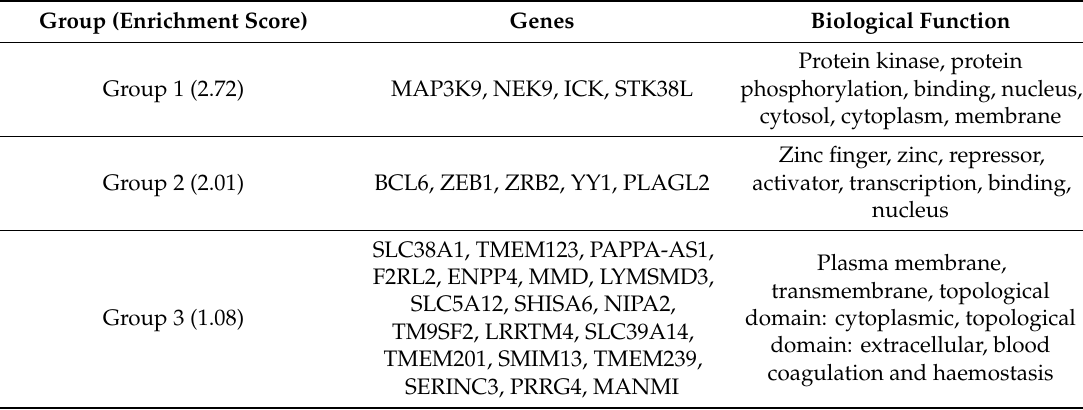
Table 3. Functional classification of genes regulated by